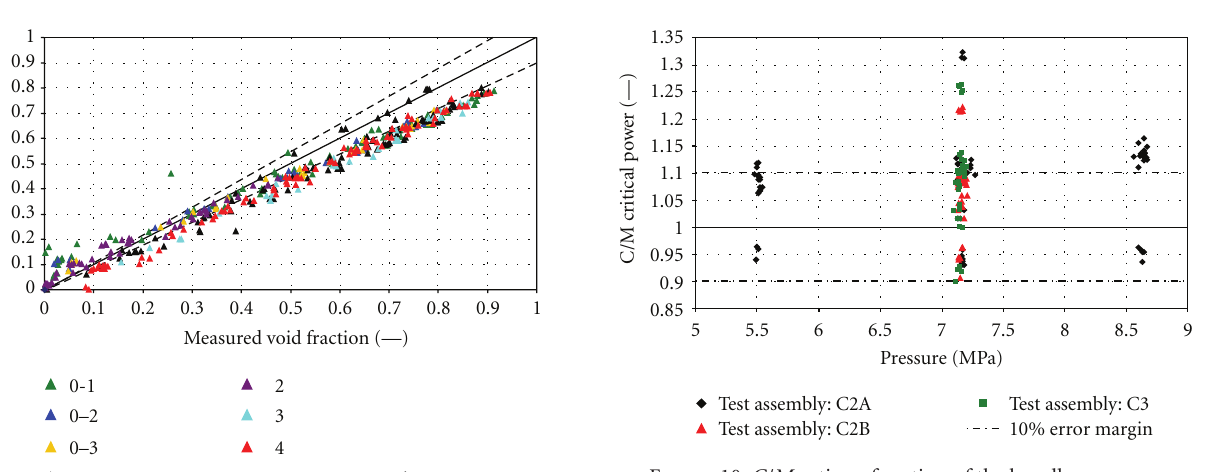
Figure 10: C / M ratio as function of the bundle pressure.